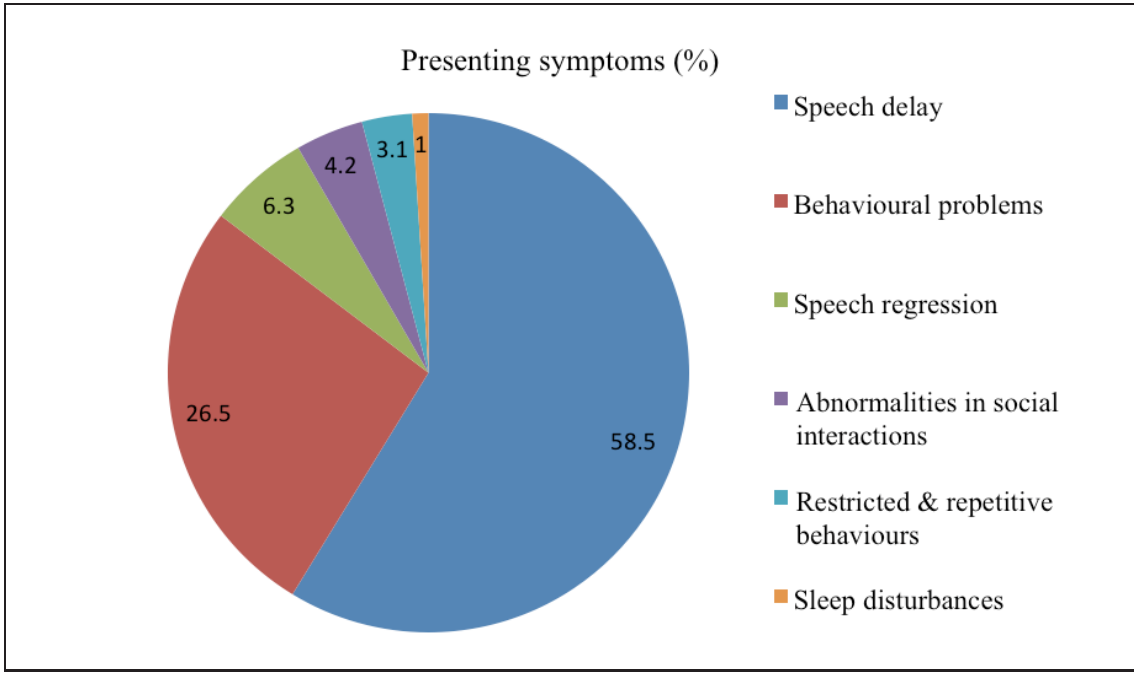
Figure 2. Presenting symptoms of children with